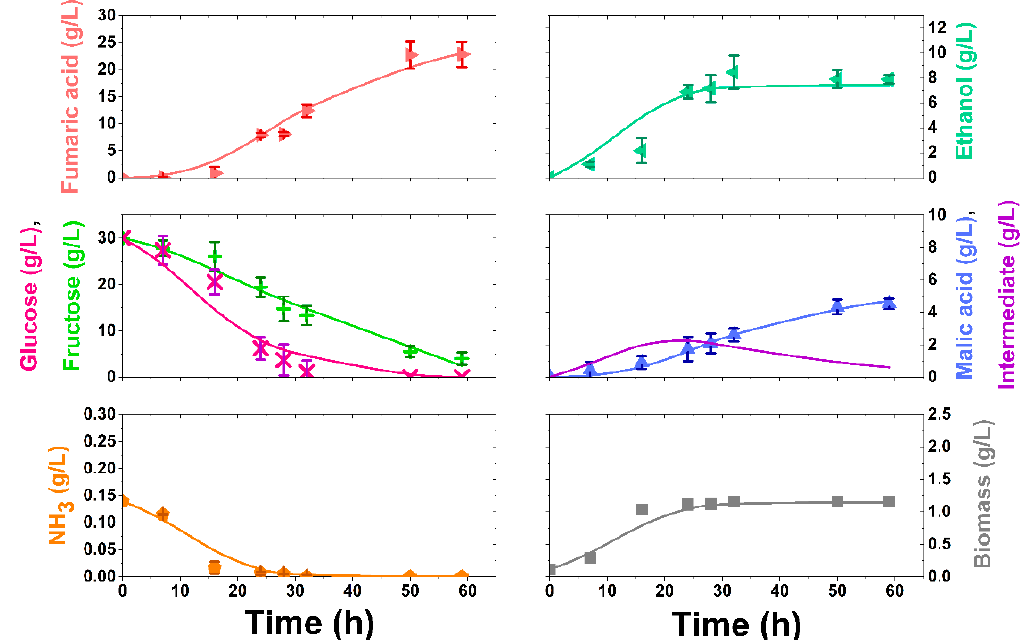
Figure 2. Experimental results (points) and simulation (lines) by means of the kinetic modelling applied to Experiment 2 ([Glucose] 0 = [Fructose] 0 = 30 g/L, [NH 3 ] 0 = 0.14 g/L, 200 rpm, 34 °C).